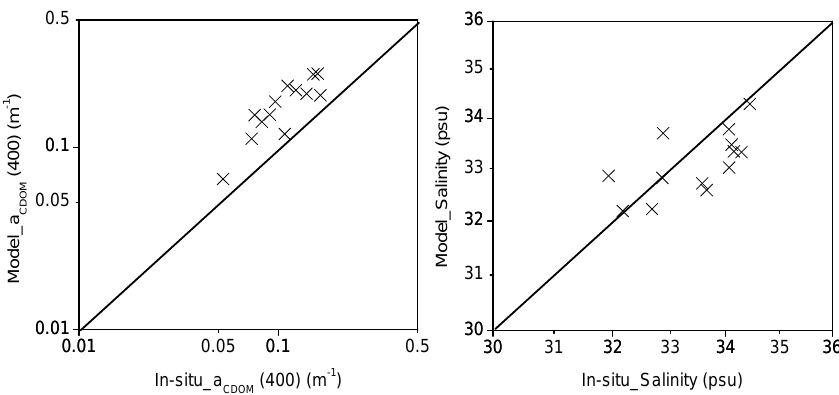
Fig. 6. Comparison of modeled a CDOM (400) (m − 1 ) and salinity (psu) with those from shipboard measurements (in-situ) obtained in the ECS during spring–summer 2002–2005 ( N =13).